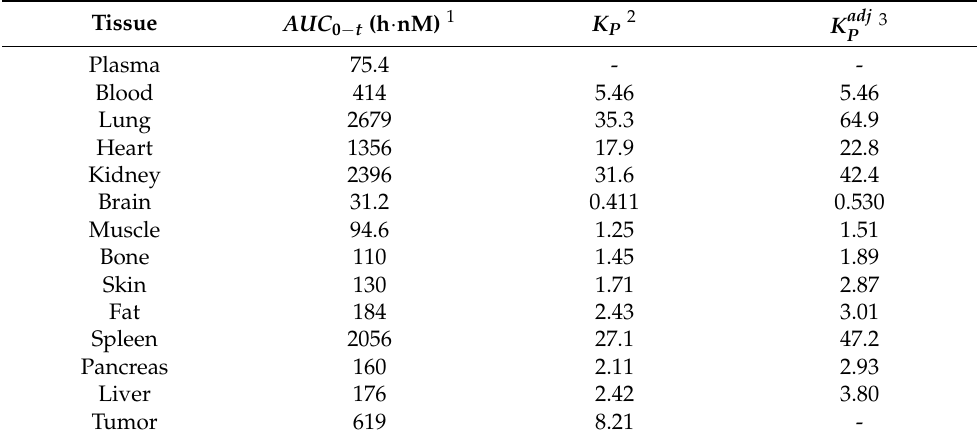
Figure 2. Observed whole-body pharmacokinetics (PK) of MMAE in mice after intravenous administration of 0.1 mg/kg MMAE dose. The figure displays the mean (SD) observed concentration (black dots) in plasma, tissues, and tumor. All the PK profiles (truncated to 24 h) are superimposed in the last panel. Table 2. AUC 0 − t and partition coefficient ( K P ) of